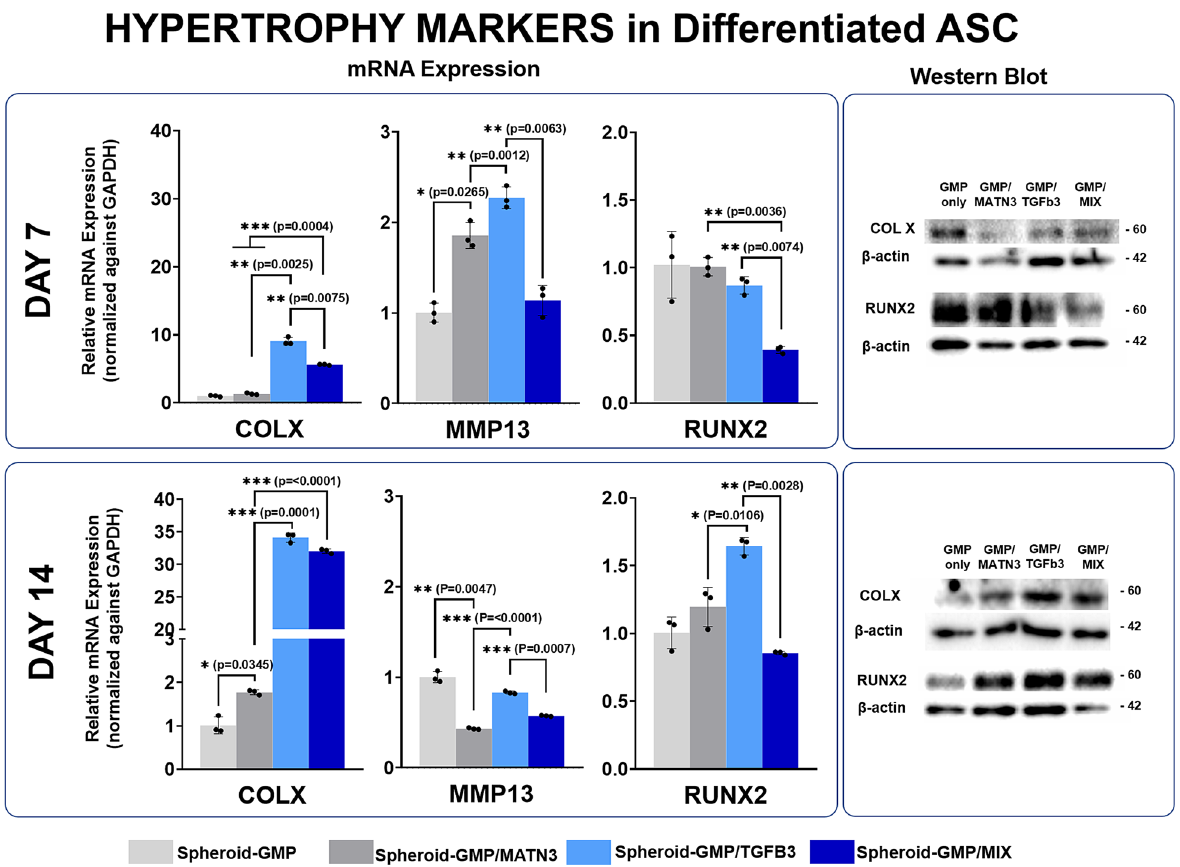
Fig. 5 Time-dependent expression of hypertrophy markers in ASC spheroids. Quantitative real-time gene expression analysis and immunoblot analysis of the hypertrophy markers COLX, MMP13, and RUNX2; seven days (top panel) and 14 days (bottom panel) post differentiation. qRT-PCR data were normalized against GAPDH expression while western blot data were normalized against B-actin control. The data are representative of three independent experiments, each experiment done in triplicate. Error bars denote the means ± standard error of mean (sem) (ns = not signi fi cant, * p < 0.05, ** p < 0.01, *** p < 0.001; **** p < 0.0001). Individual data point and p -values for signi fi cance were indicated in the